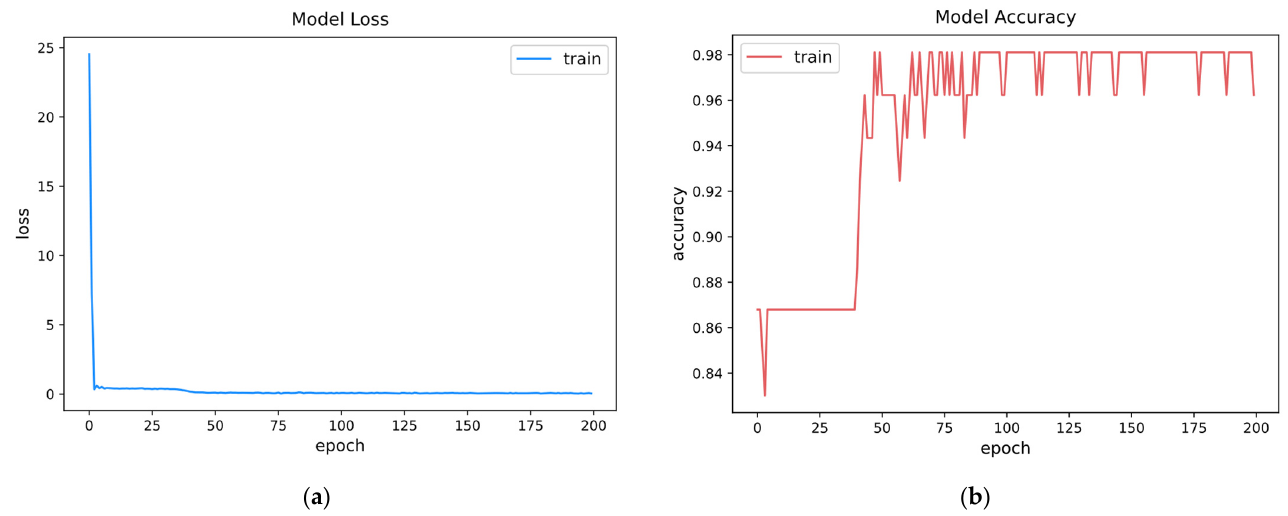
Figure 7. The graphs of the training process and prediction result. ( a ) Training loss; ( b ) model accuracy.